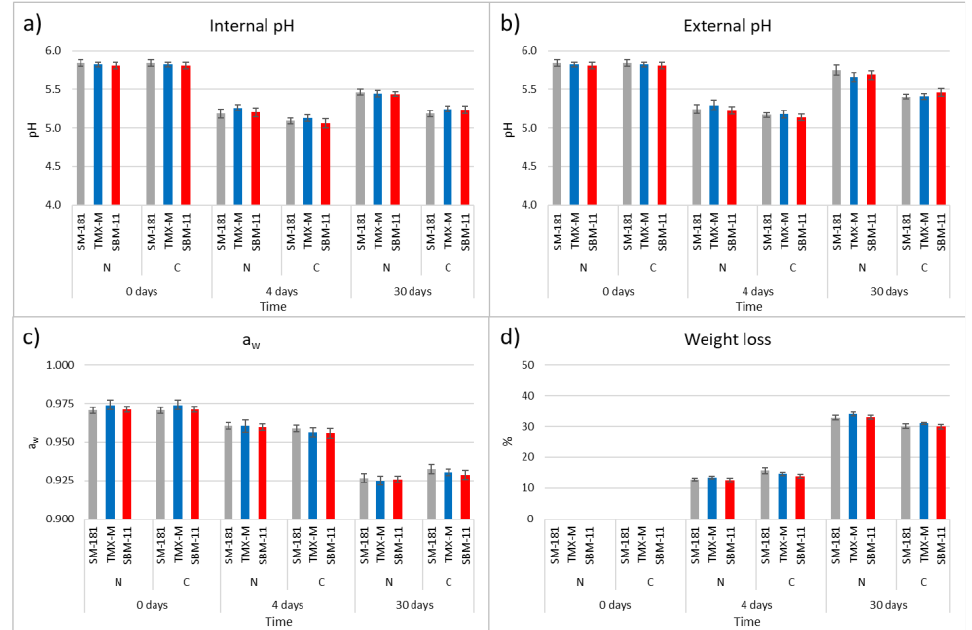
Figure 1. Internal pH ( a ), external pH ( b ), a w ( c ) and weight loss ( d ) monitored on day 0, after 4 days and at the end of ripening (30 days) of fermented sausages obtained using three different starter cultures (SM-181, TMX-M and SBM-11) and stuffed into natural or collagen casings. The data are the mean of three different sausages for each production and standard errors bars are reported.